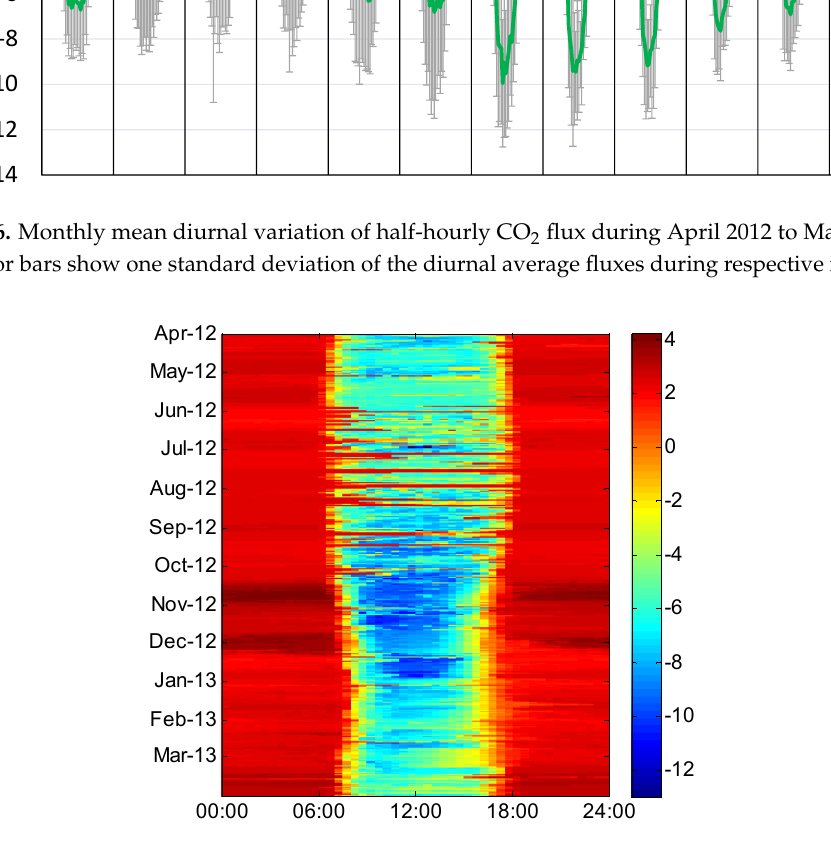
Figure 7. Gap ‐ filled net ecosystem exchange (NEE) fingerprint of Sundarbans mangroves showing time of the day ( x ‐ axis) and month ‐ wise ( y ‐ axis) CO 2 fluxes in μ mol ∙ m − 2 ∙ s − 1 during the study period. Water vapor fluxes (or evapotranspiration (ET) rates), defined as the sum of evaporation and transpiration over an ecosystem, varied between a maximum of 5.5 mmol ∙ m − 2 ∙ s − 1 in October 2012 to a minimum of 2.5 mmol ∙ m − 2 ∙ s − 1 in July 2013 (Figure 8). The majority of H 2 O fluxes were found to be